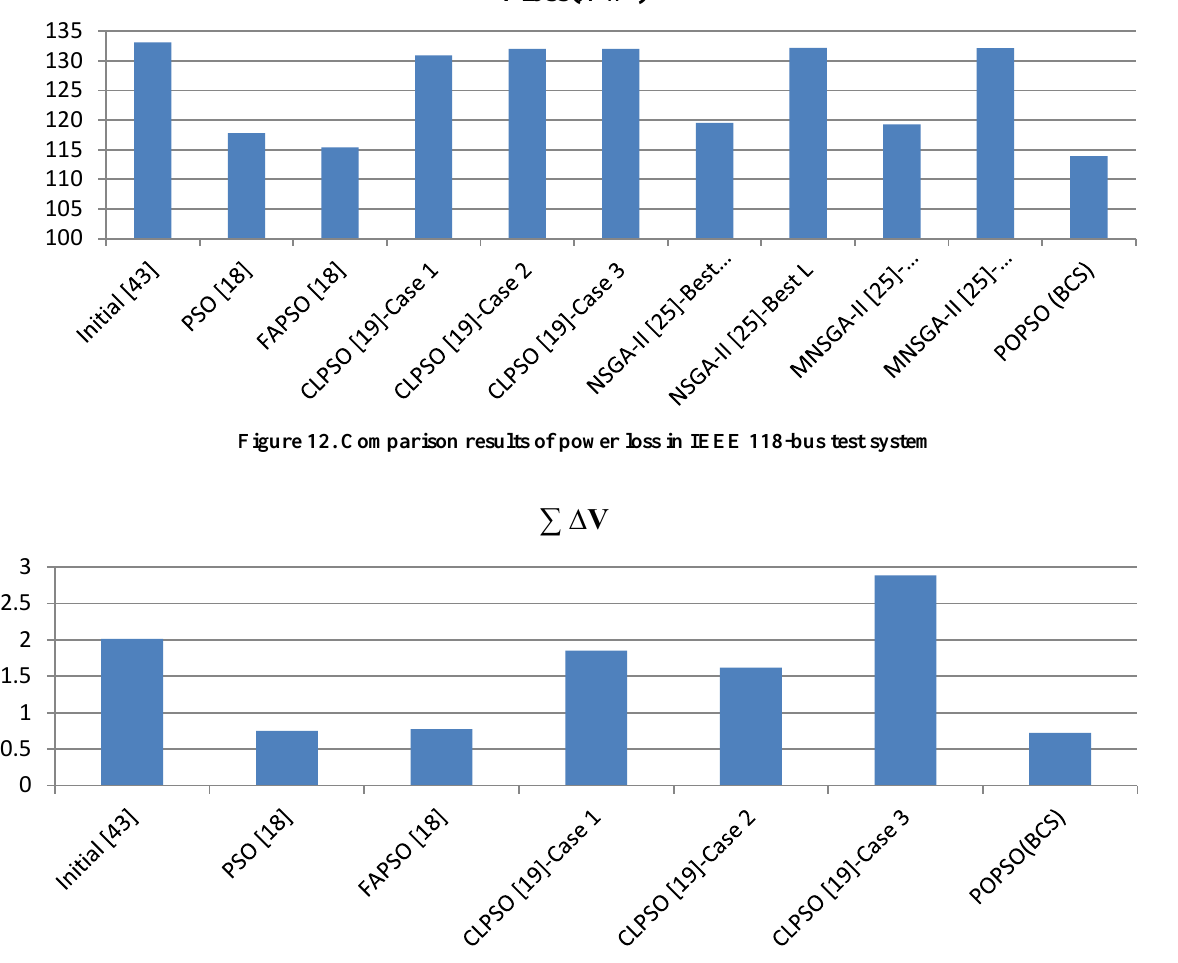
Figure 13. Comparison results of voltage deviation in IEEE 118-bus test